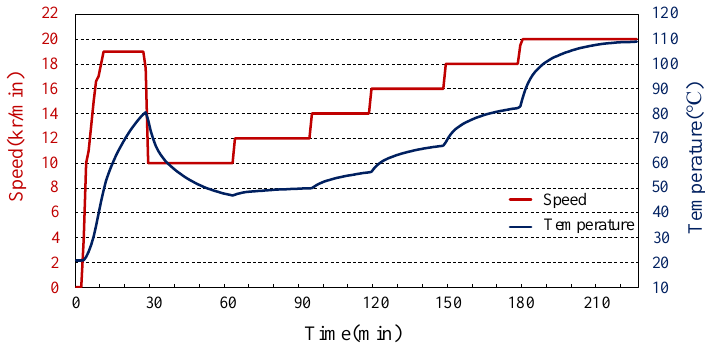
Figure 12. Measured speed and temperature.